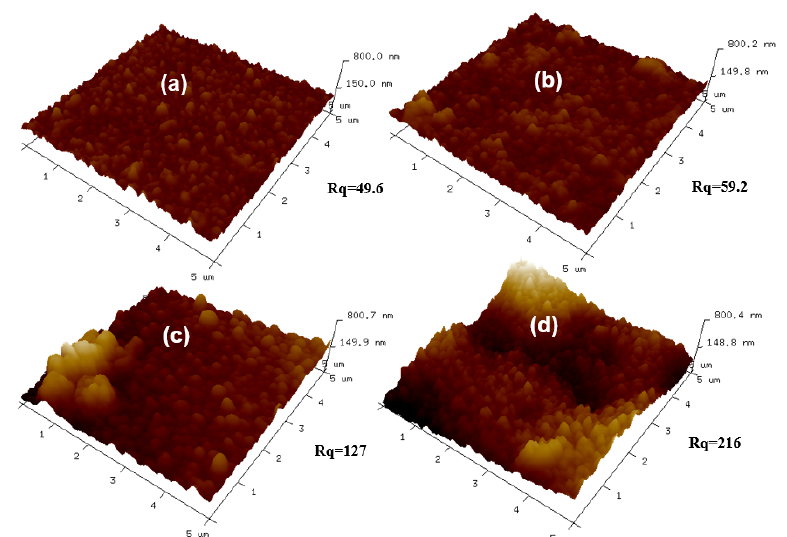
Figure 6. SEM images of the back surfaces of membranes with different concentrations of R812S NPs: ( a ) no NPs, ( b ) 0.02% ( w / v ), ( c ) 0.1% ( w / v ) and ( d ) 0.5% ( w / v ); ( e ) histograms of pore size in the back surfaces of membranes. The pore size distributions are generated based on 100 pore counts on the backside of the PA layer.